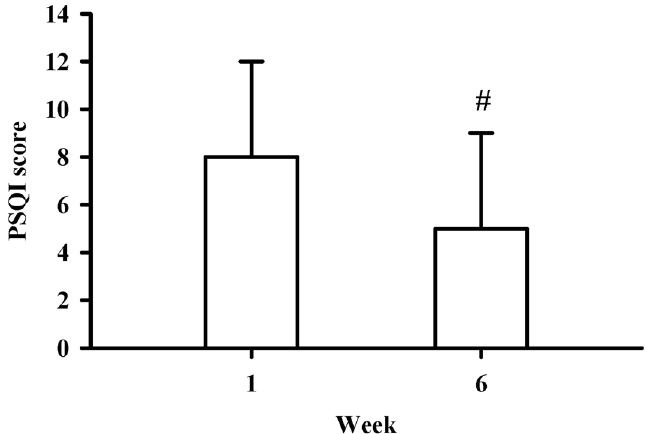
Figure 1. The PSQI was measured before and after 6 weeks of activity. # p < 0.01 compared to week 1. Data are presented as the mean ± SD.